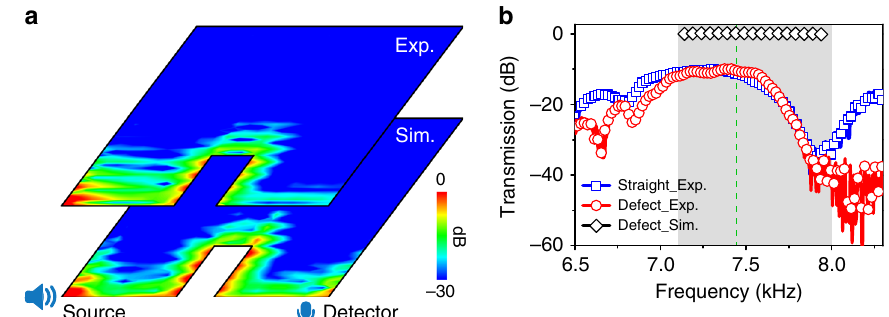
Fig. 4 Experimental demonstration of backscattering robustness of the acoustic boundary waves for the whole-cell boundary. a The fi eld distributions 7.44 kHz (dashed line in b ) from the simulation and experiment for a sample possessing a rectangular defect. The loudspeaker and microphone symbols denote the source and detector positions, respectively. b The simulated (diamond) and measured (circle) transmissions for the defect path, compared with measured one, are for a sample having a straight path with the same length. The good agreement of the measured results in the bulk gap (shadowed region) indicates the negligibly weak backscattering of the acoustic boundary waves.